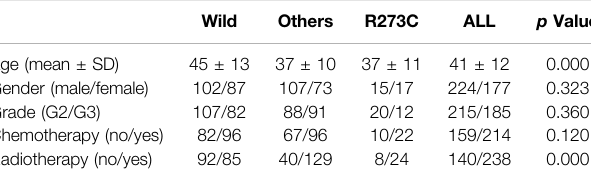
TABLE1| ComparisonofclinicalcharacteristicsamongTP53mutationsubsetsin the IDH1/2 mutation background. Wild Others R273C